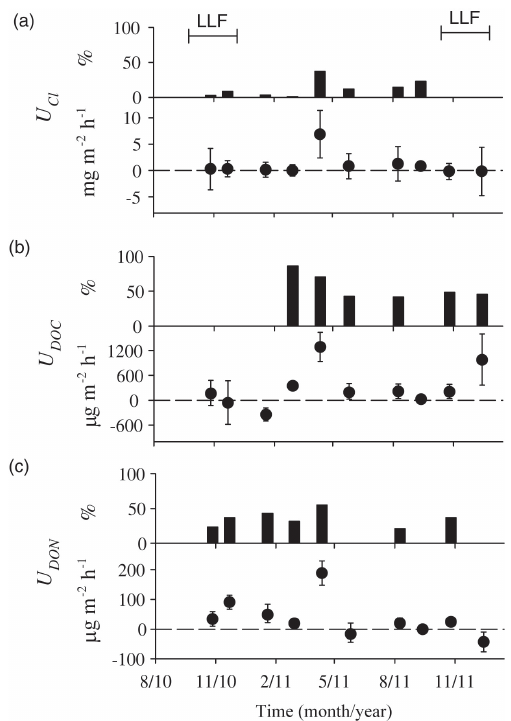
Figure 7. Temporal pattern of in-stream net uptake ( U , either in µg or mgm − 2 h − 1 ) for (a) chloride, (b) dissolved organic car- bon (DOC), and (c) dissolved organic nitrogen (DON) at the whole reach scale. Whiskers are the uncertainty associated with the esti- mation of stream discharge from NaCl slug additions as in Bernal et al. (2015). Values of U >0 indicate that gross uptake prevails over release, while U <0 indicates the opposite. For cases with U >0, the contribution of in-stream net uptake to decrease stream solute fluxes (i.e., U × A/F in , in %) is shown (black bars). The leaf litter fall (LLF) period is